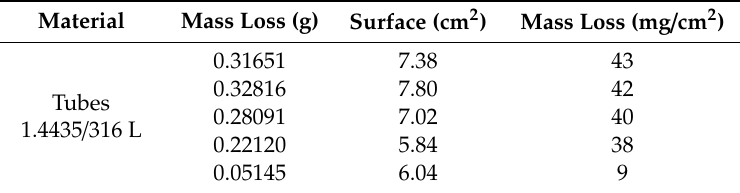
Figure 17. Metallographic section of the tube (#3, 1.4435/316L steel) after Strauss’s test. Table 8. Tube mass loss after Strauss test.